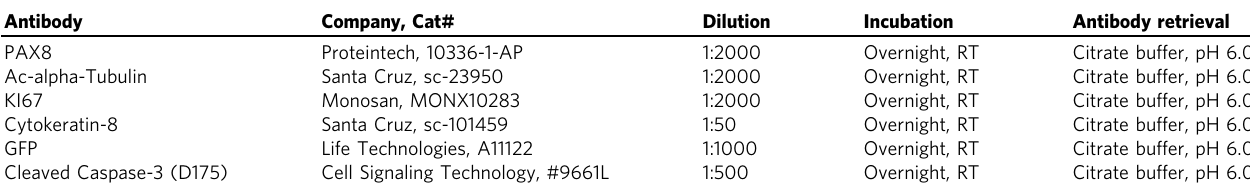
Table 2 Antibody speci fi cations.